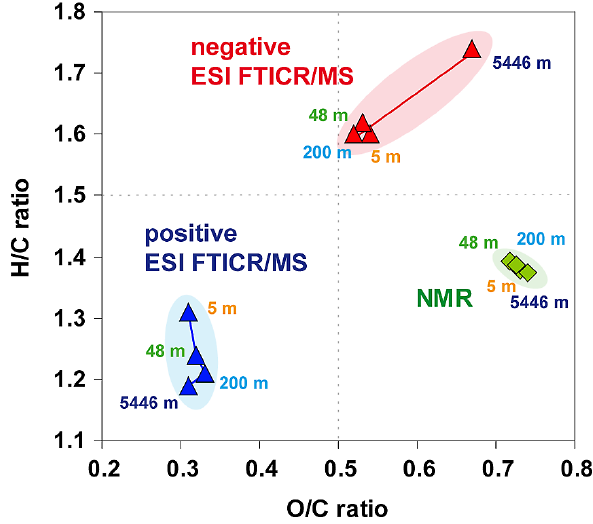
Fig. 19. Average H/C and O/C elemental ratios of marine SPE- DOM as derived from NMR spectroscopy (Table 3), negative ESI (Table 4) and positive ESI (Table 5) FTICR mass